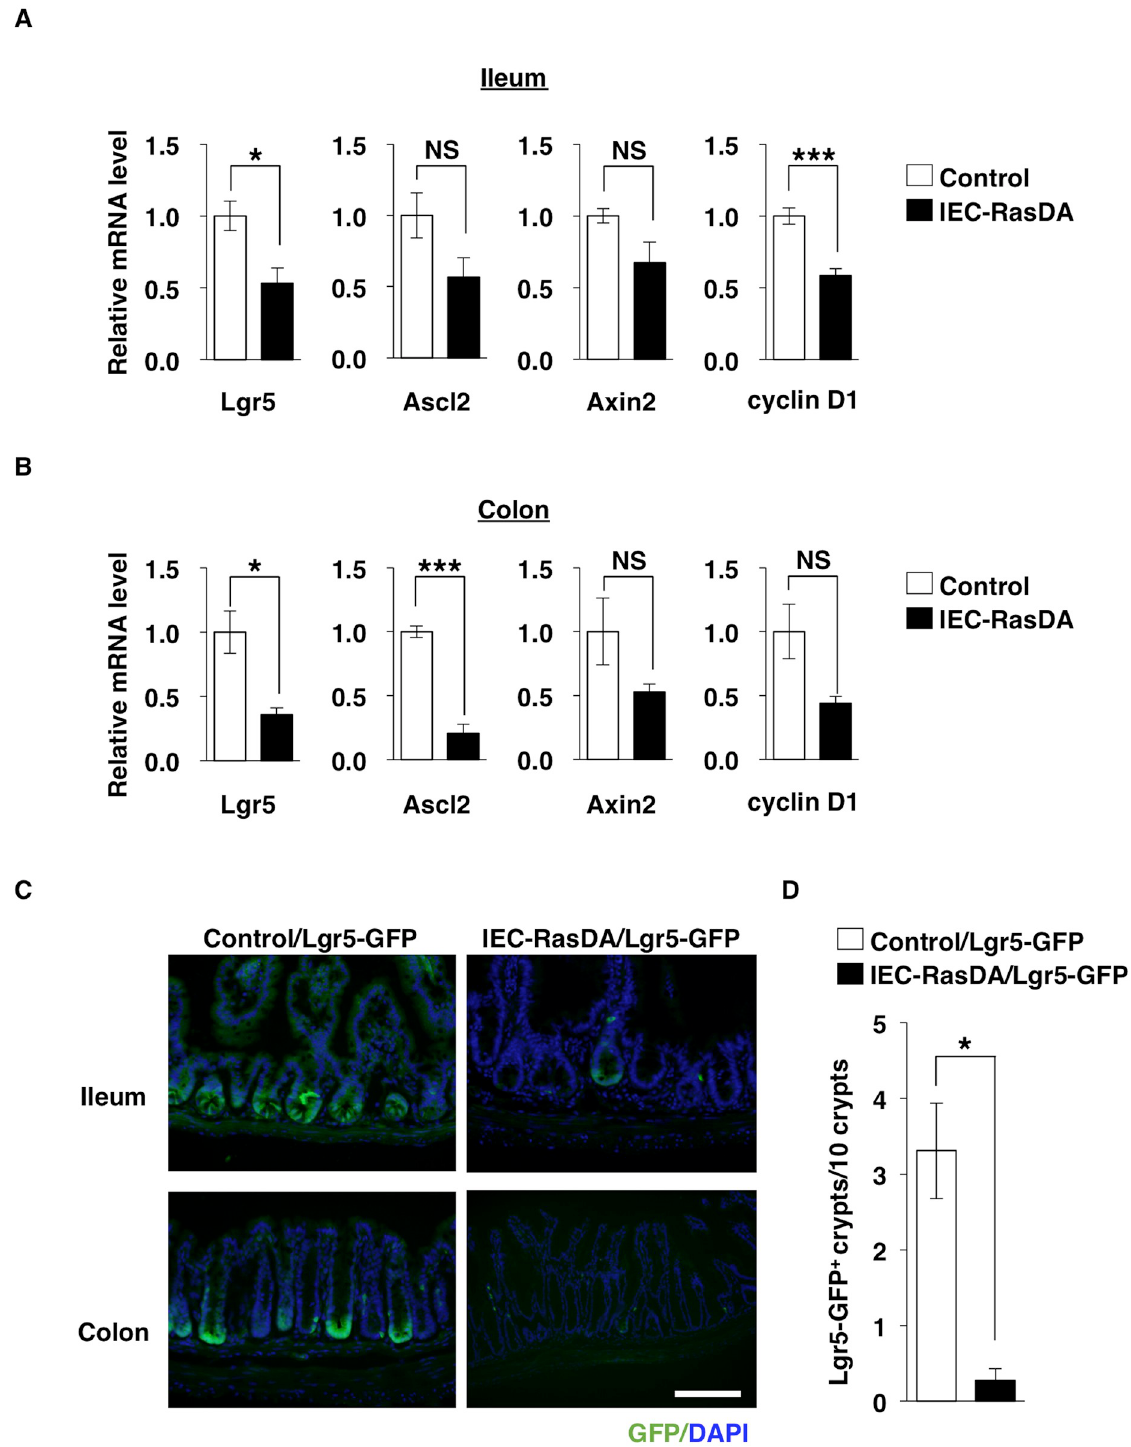
Fig 4. Down-regulation of Wnt-target genes in crypts from IEC-RasDA mice. ( A, B ) Expression of Lgr5, Ascl2, Axin2, and cyclin D1 mRNAs in crypts isolated from the ileum ( A ) or the colon ( B ) of control or IEC-RasDA mice at 11- to 16-week-old. Data are means ± s.e. from three separate experiments. � P < 0.05; ��� P < 0.001; NS, not significant (Student’s t test). ( C ) Frozen sections of the ileum and colon from control/Lgr5-GFP and IEC-RasDA/Lgr5-GFP mice at 10- to 11-week-old were examined for GFP fluorescence (green). These sections were stained with DAPI (blue) to detect nuclei. Scale bar, 100 μ m. ( D ) The number of Lgr5-GFP–positive ileal crypts per 10 crypts. Data are